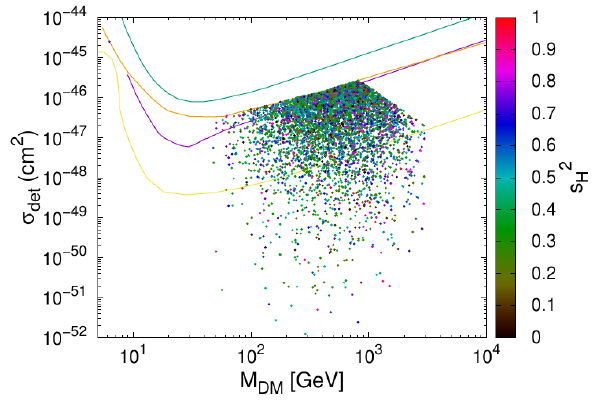
Figure 5 . The DD cross section vs the DM mass for the scalar DM BPs used in figure 2. The violet, blue and orange lines correspond to the bounds from LUX-ZEPLIN [38], Xenon-1T bound [58] and PandaX-4T [57], respectively, while the yellow one represents the neutrino floor